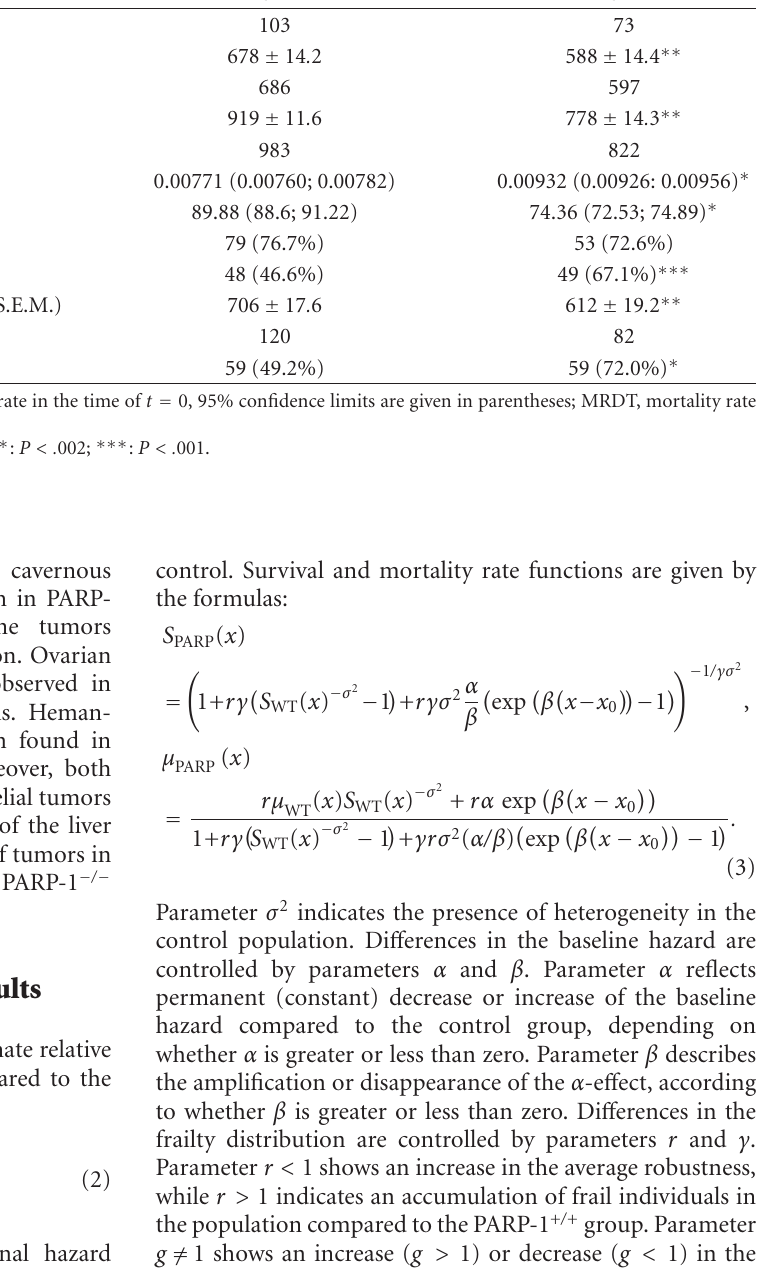
Table 3: Parameters of survival, life span and tumorigenesis in PARP-1 − / − and PARP-1 + / + mice. Parameters PARP-1 + / + Number of mice Mean life span (days, mean ±